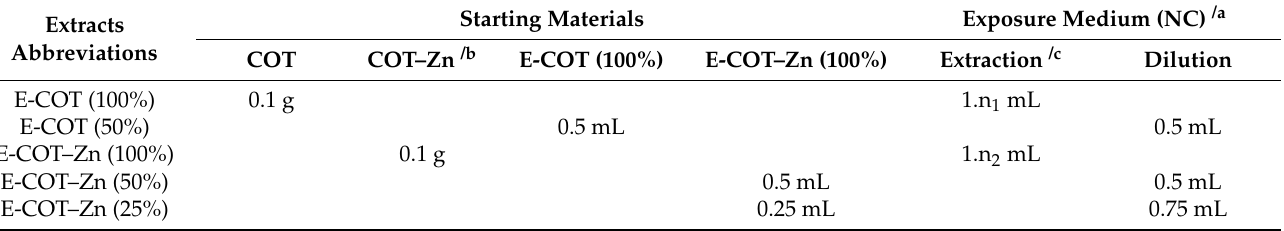
Table 2. Extract